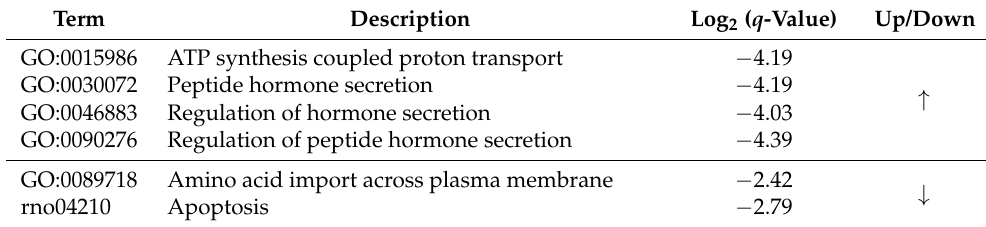
Table 5. Highlighted functional annotation within GO terms (Methylome results).